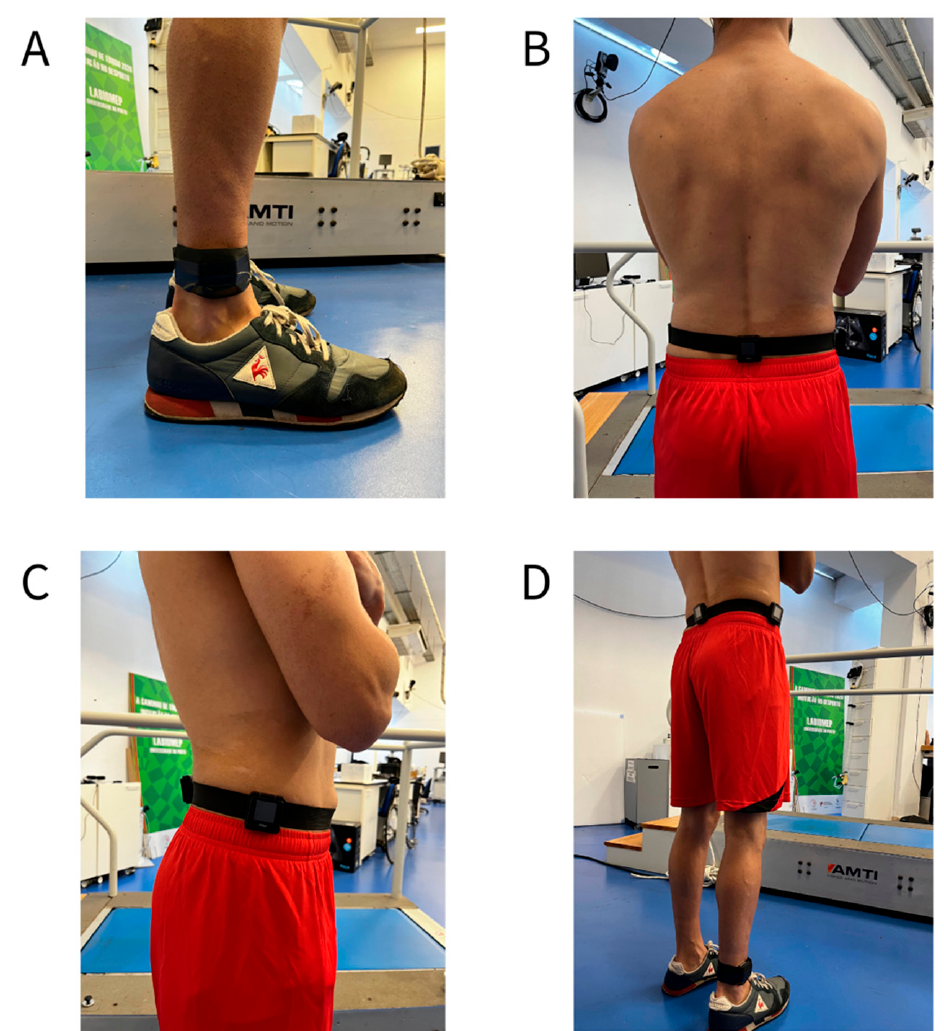
Figure 3. Accelerometers’ positioning on the body: Details of accelerometer positioning on the ankle, lower back, and hip are displayed in Panels ( A – C ), respectively. Panel ( D ) shows all accelerometer placements simultaneously.